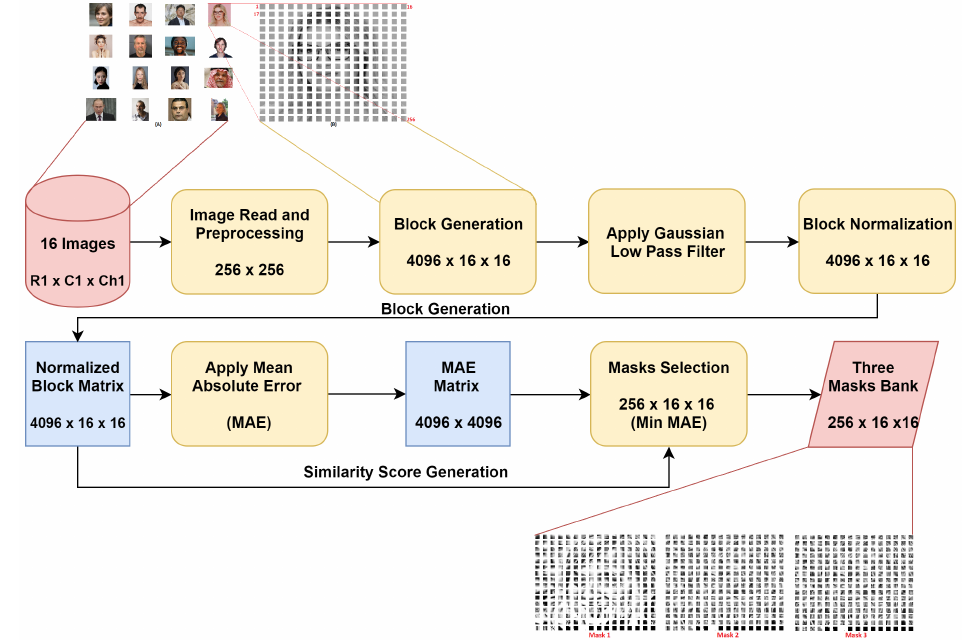
Figure 3. The multi-chimera mask bank